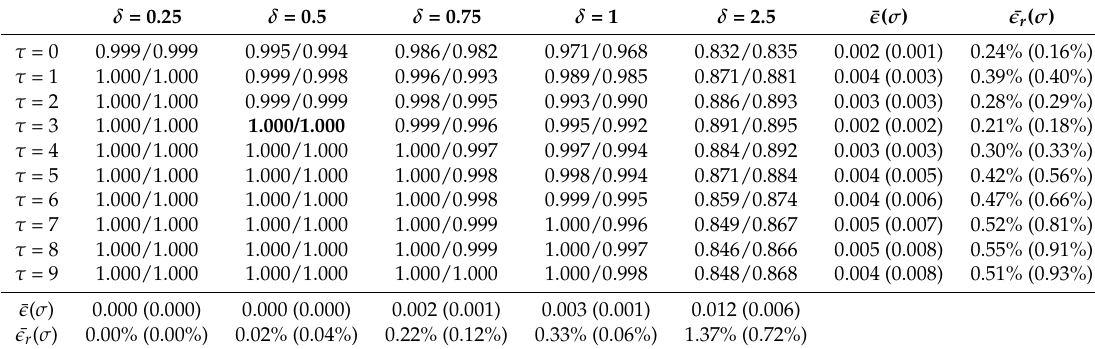
Table 2. Case study I. Level Precision (LP).